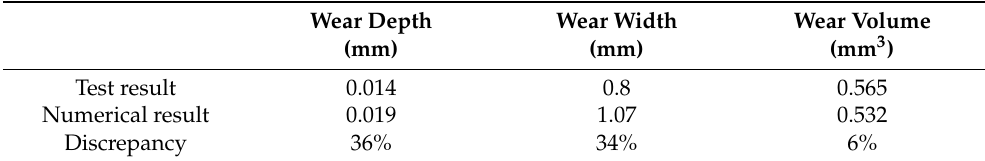
Table 4. Summary of numerical and test